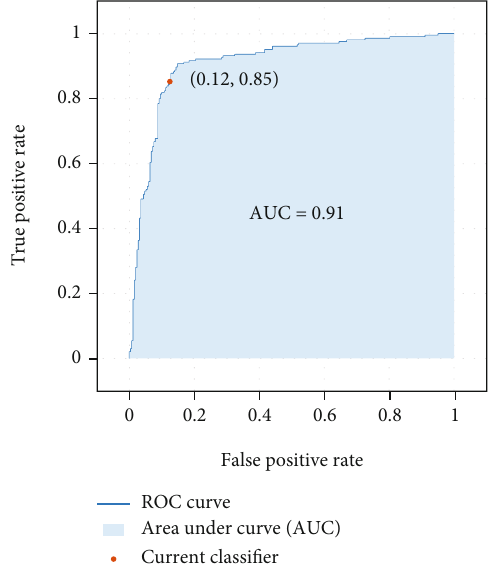
Figure 11: ROC curve of the identi fi cation